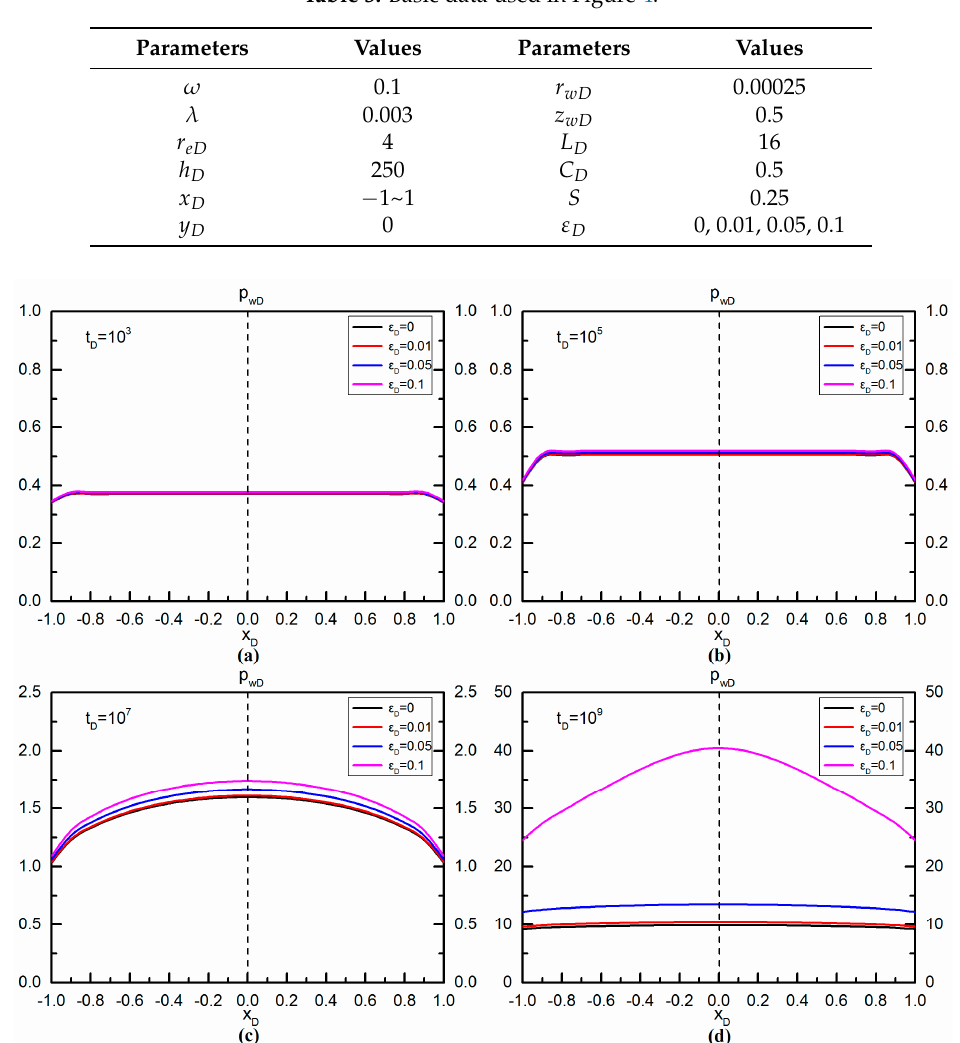
Figure 4. Effect of dimensionless elasticity parameter ( ε D ) on horizontal wellbore pressure-drop profiles at different time. ( a ) t D = 10 3 ; ( b ) t D = 10 5 ; ( c ) t D = 10 7 ; ( d ) t D = 10 9